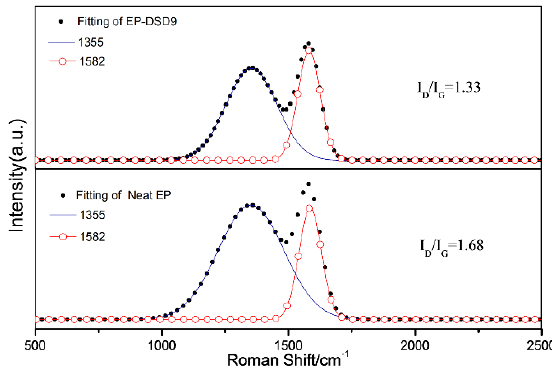
Figure 6. Raman spectra of neat EP and EP–DSD9.